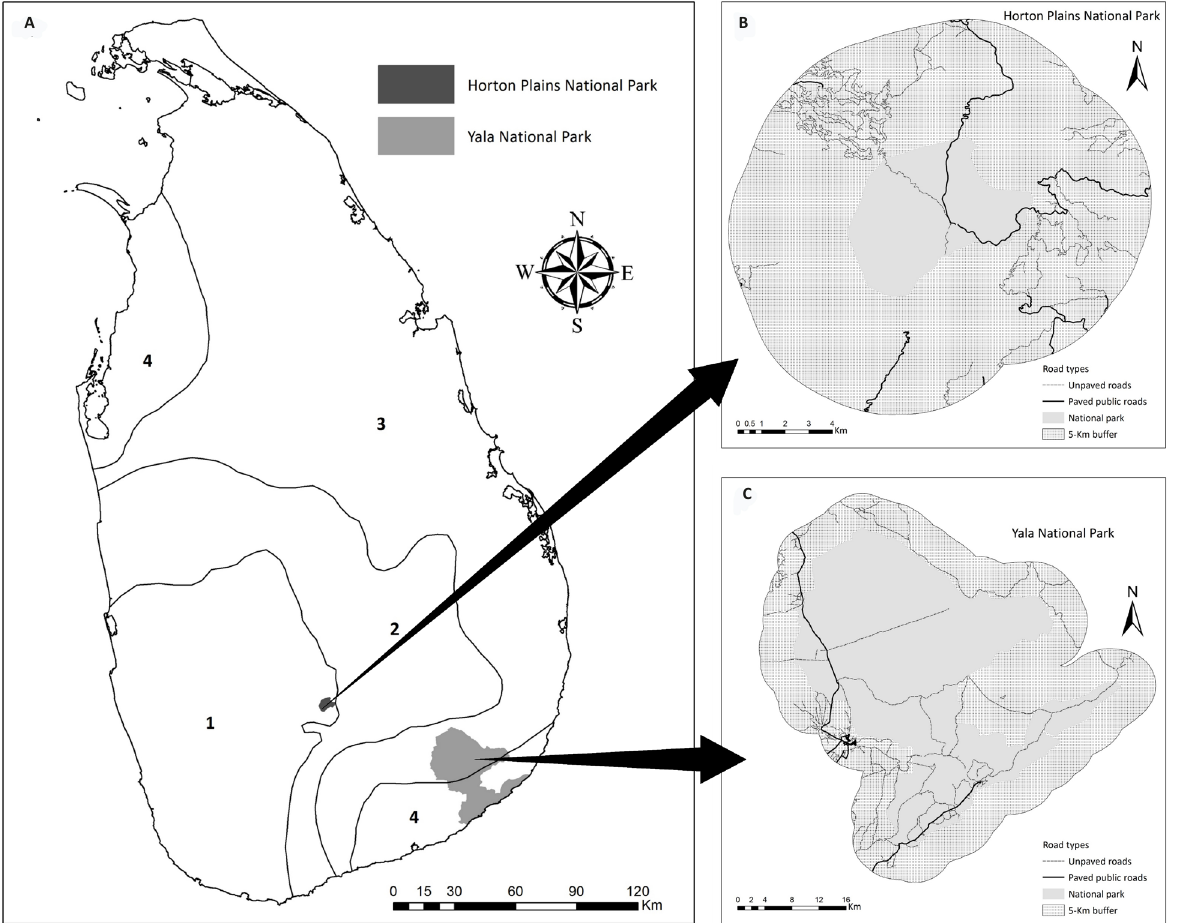
Figure 1. Study areas for the survey of roadkills: (A) the location of Horton Plains National Park (HNP) and Yala National Park (YNP) in Sri Lanka. Bioclimatic zones: 1 - wet zone, 2 - intermediate zone, 3 - dry zone, and 4 - arid zone in Sri Lanka. (B) Horton plains National Park and (C) Yala National Park with the associated road network. The 5-km-buffer is the 5-Km-wide area adjoining the park that was surveyed for